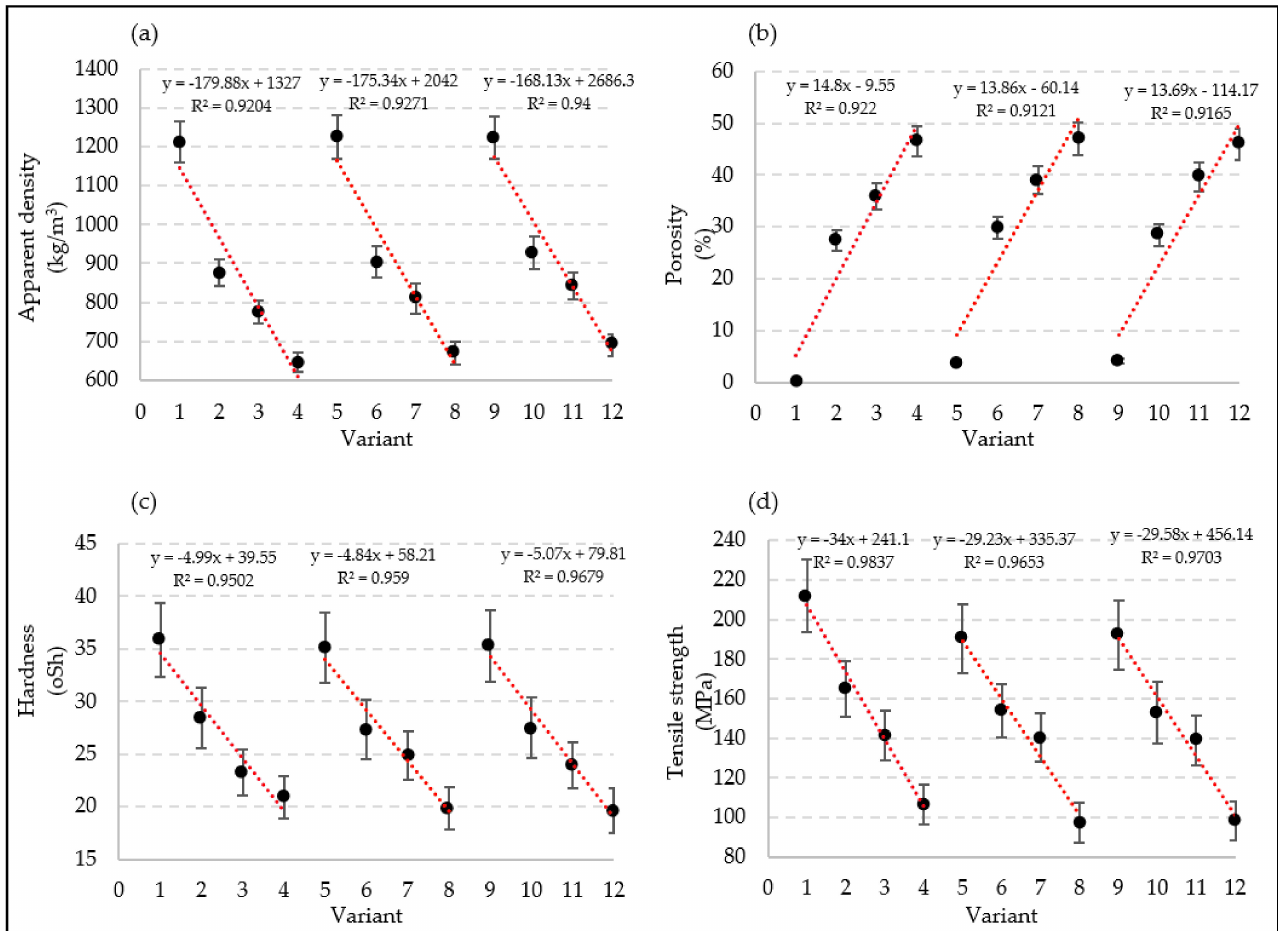
Figure 7. Changes in mechanical properties and correlations depending on the used variant of the filling modification: ( a ) apparent density; ( b ) porosity; ( c ) hardness; ( d ) tensile